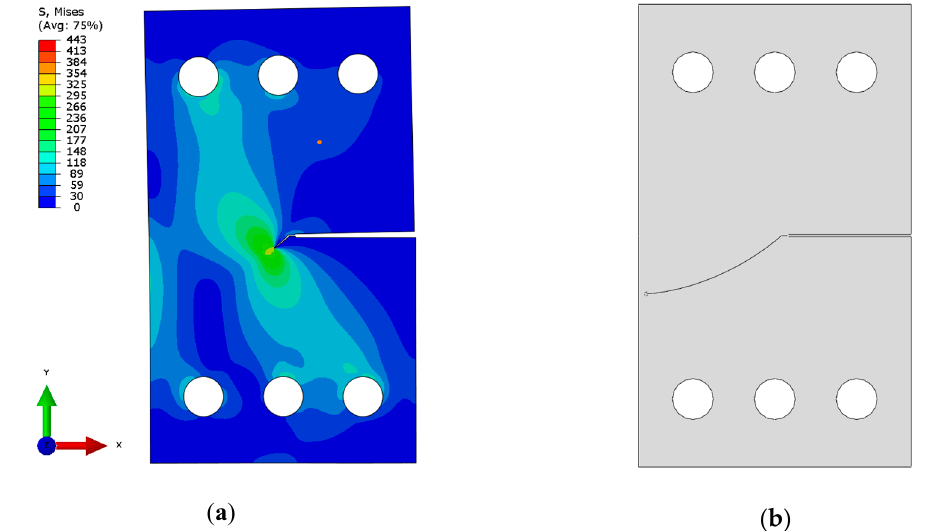
Figure 7. ( a ) Huber–Mises stress distribution in CTS specimen (load angle θ = 45°) with 3 mm long mixed ‐ mode fatigue crack length; ( b ) predicted (posterior—based on the real crack path) crack trajectory in the discrete model used for stress intensity factors calculation.